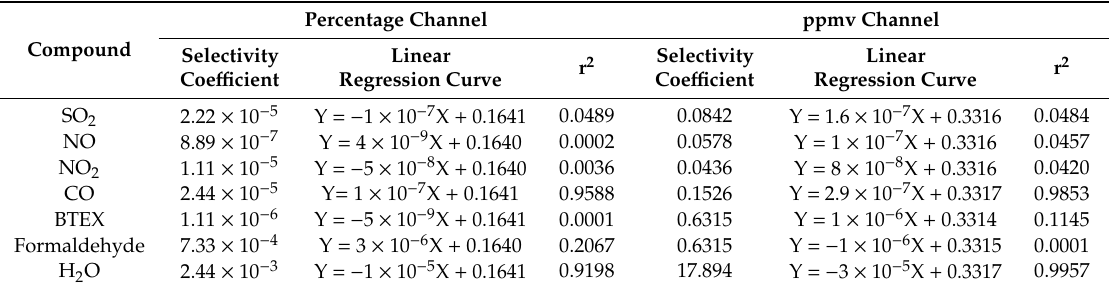
Table 3. Response of analyzer signal to interference gases with respect to percentage and ppmv